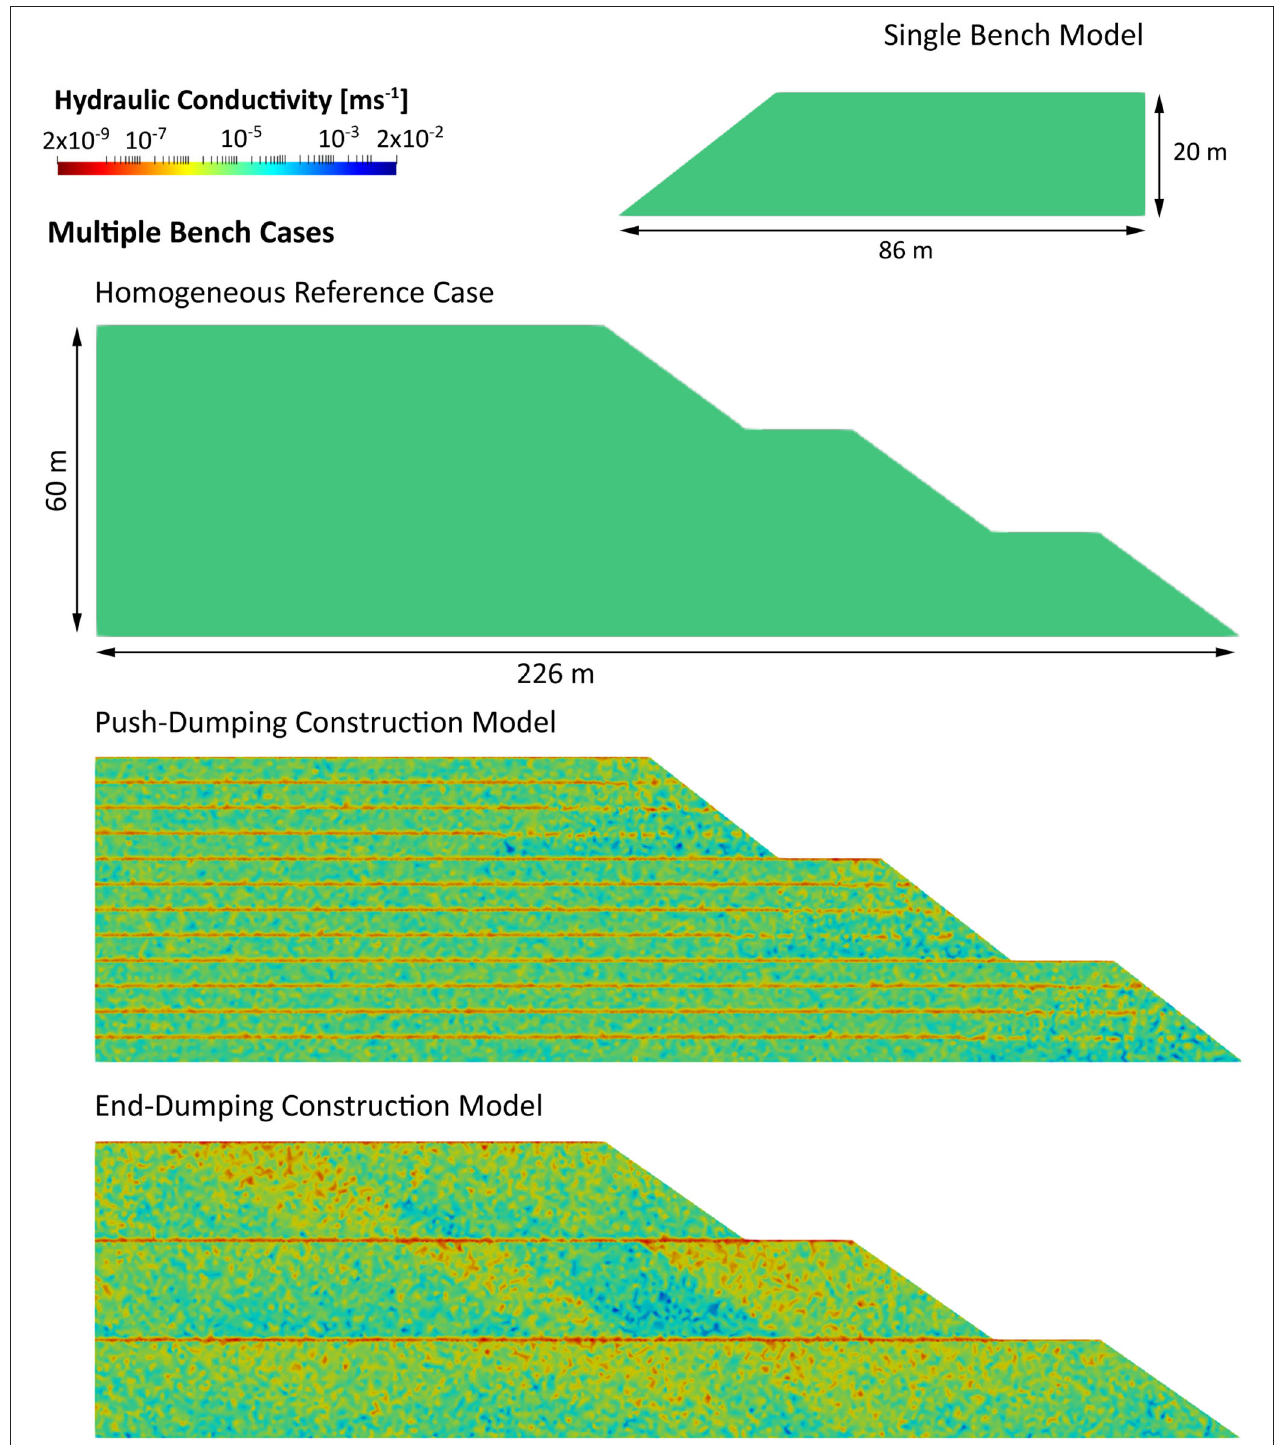
FIGURE 4 | Hydraulic conductivity distribution for multiple bench models in cross-section. These cases expand upon the structure single bench cases from Figure 3 to include three stacked benches, with a homogeneous multi-bench model for comparison.